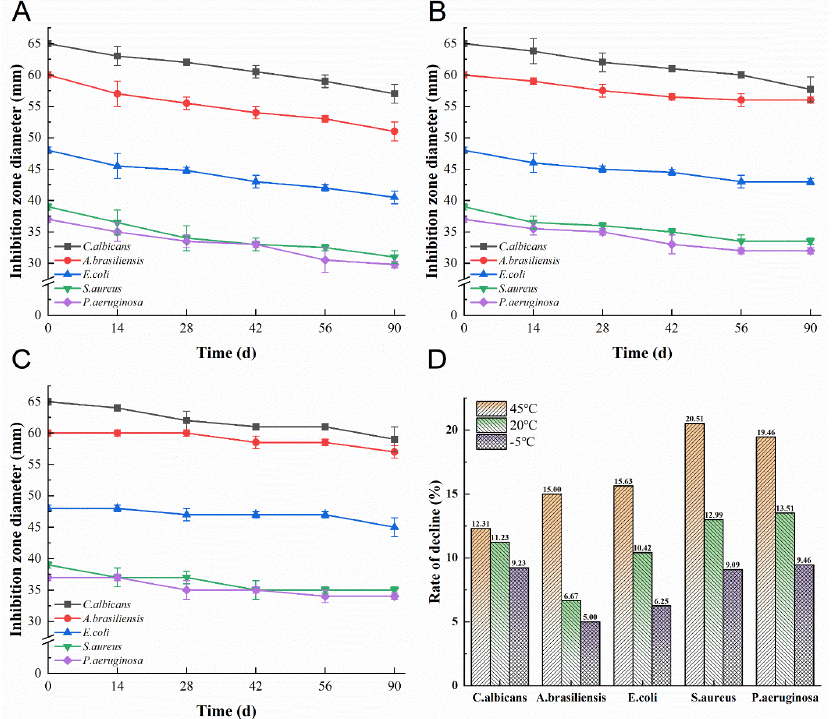
Figure 3. The effect of NMs on antibacterial activity at different temperatures. ( A ) 45 °C, ( B ) 20 °C, ( C ) − 5 °C, ( D ) rate of decline. Data obtained from triplicate experiments are expressed as mean ± SD ( n = 3).